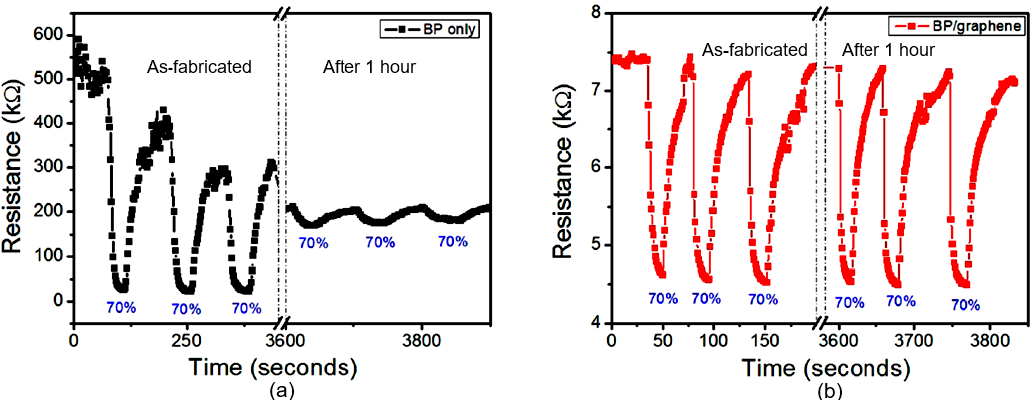
Figure 21. Transient response and estimated stability of the humidity sensor after 1 h based on ( a ) BP only and ( b ) BP/graphene heterojunction. Reproduced from Ref. [118]. Published by Springer Nature